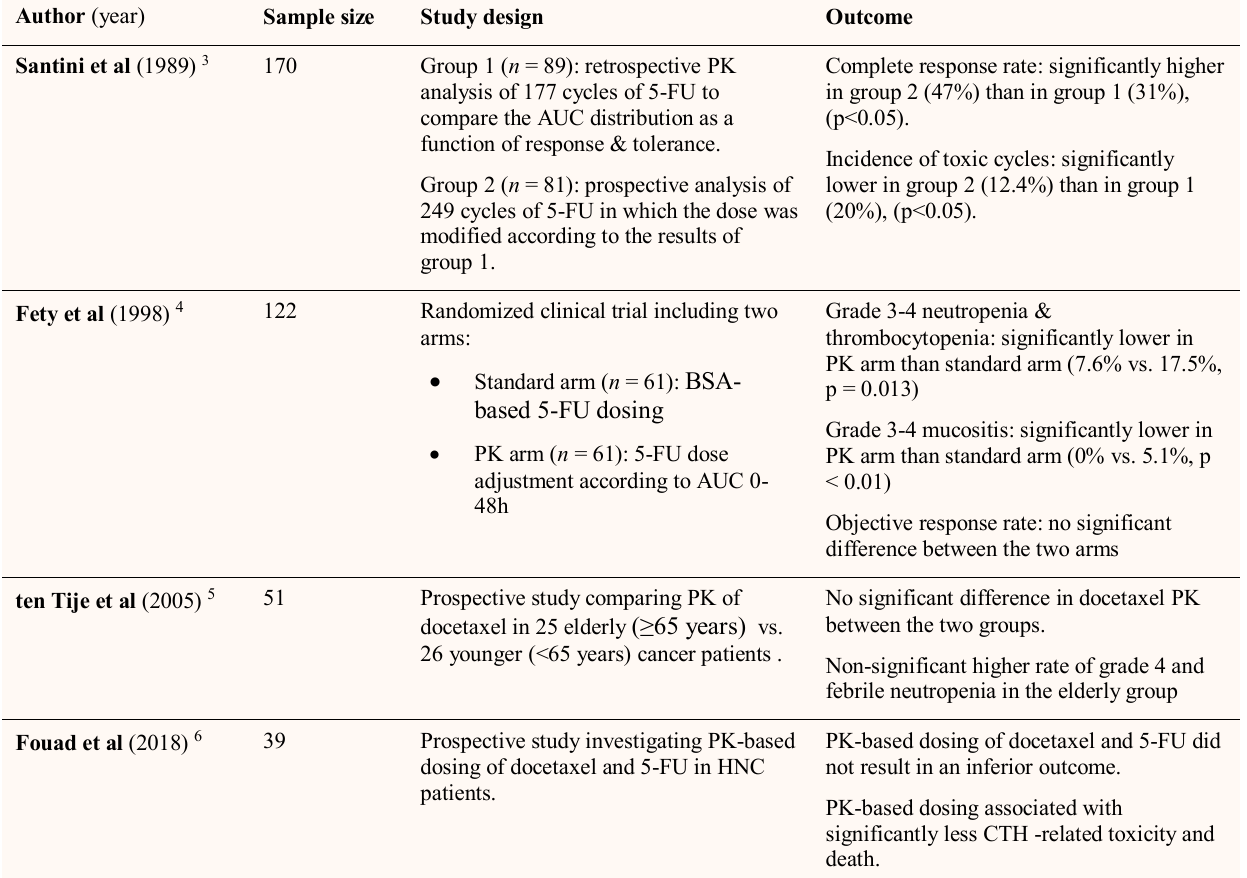
Table 1: Studies that investigated the role of pharmacokinetic-based chemotherapy dosing in head and neck cancer Author